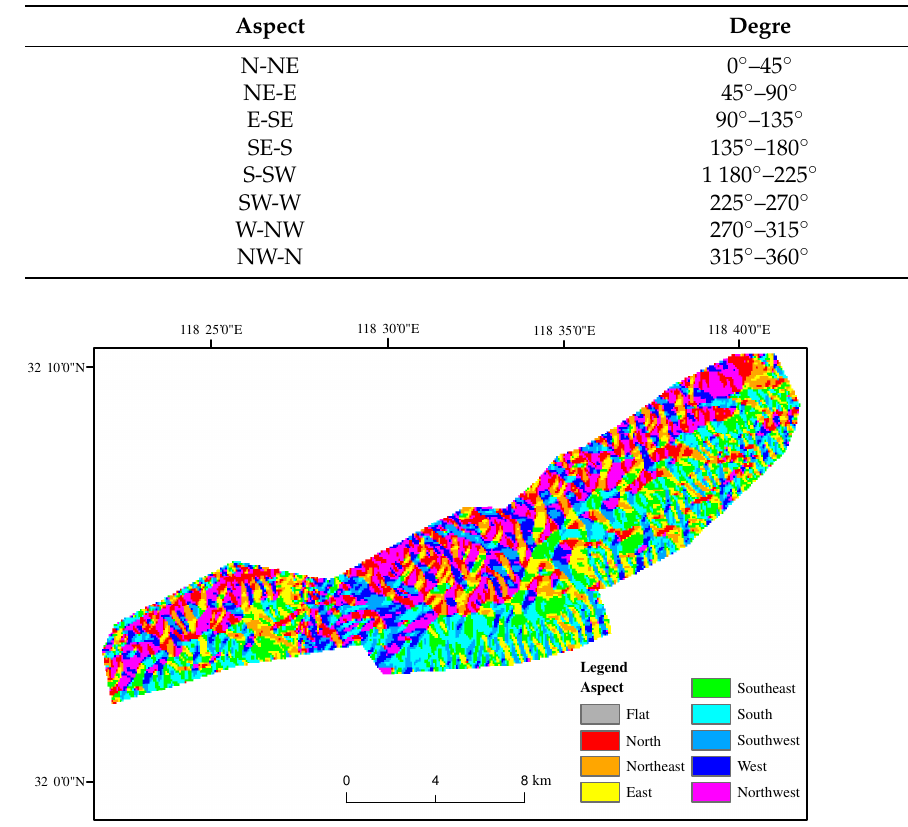
Table 3. Classification of aspect.